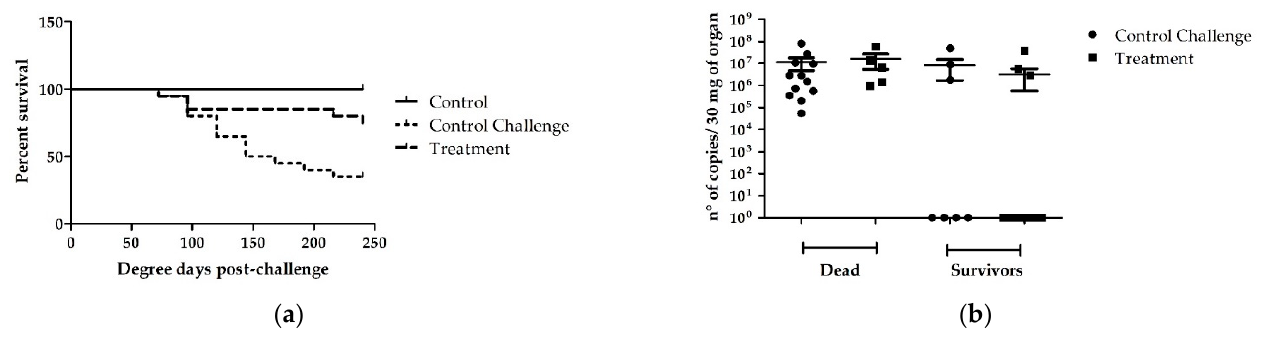
Figure 4. Effect of the administration of [Cu(NN 1 ) 2 ](ClO 4 ) complex in the rainbow trout diet against infection with F. pyschrophilum : ( a ) Percentage of survival, ( b ) bacterial loads. Statistically significant differences were determined by comparing the curves of treatment versus challenge control, using a long-rank test (Mantel-cox) and Gehan-Breslow-Wilcoxon test ( p <